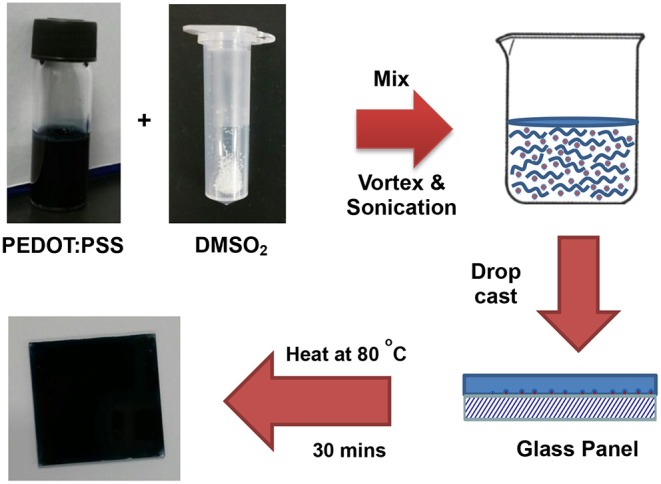
Fabrication process for sulfone DMSO2 as additive to PEDOT:PSS.